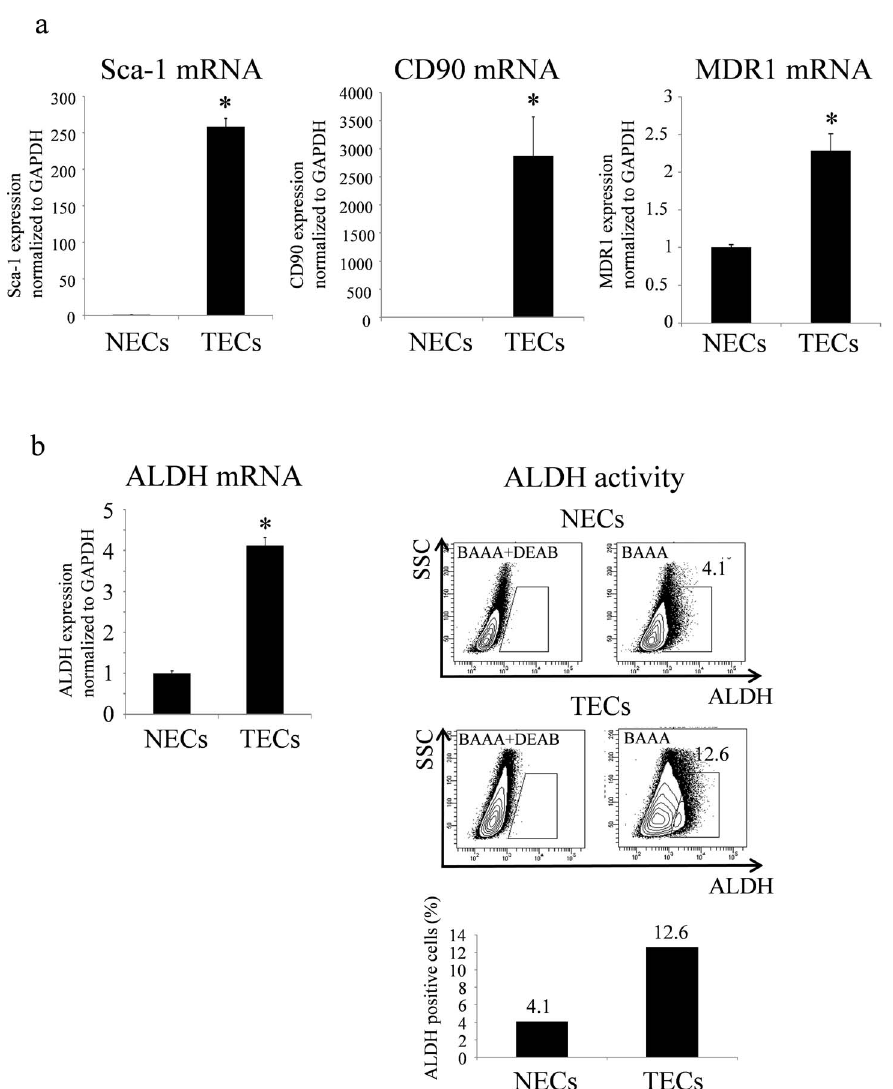
Figure 2. TECs exhibit a stem like phenotype. a. Relative expression of Sca-1, CD90, and MDR1 to GAPDH in TECs and NECs was measured using real-time RT-PCR (*p , 0.01). b. ALDH mRNA expression was upregulated in TECs as determined by real-time RT-PCR (*p , 0.01). ALDH activity was higher in TECs than that in NECs based on analysis of ALDH activity by flow